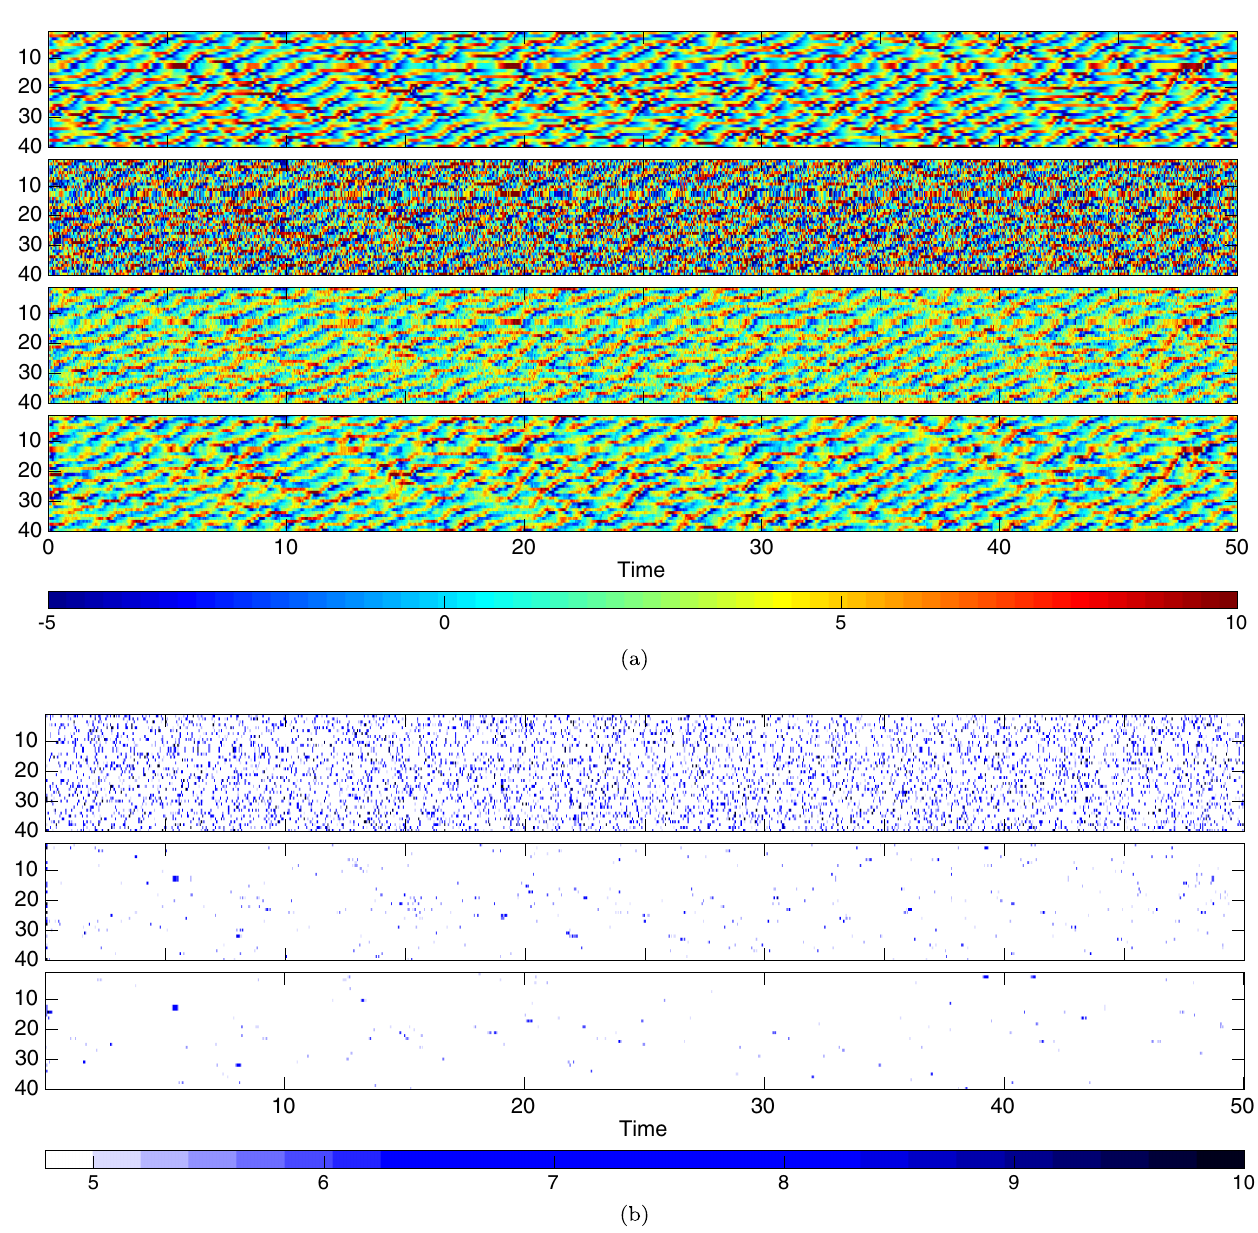
FIG. 1. Results of filtering the full 40-dimensional Lorenz-96 system. (a) Spatiotemporal plot of the system dynamics. The horizontal axis represents time, and the vertical axis represents the spatial position. From top to bottom, (1) the true system trajectory, (2) observations perturbed by 100% noise, (3) Kalman-Takens output, and (4) parametric filter output. (b) Spatiotemporal plot of the resulting absolute errors. For readability, only absolute errors greater than 5 are shown. From top to bottom, error in (1) the observed signals, (2) Kalman-Takens output, and (3) parametric filter